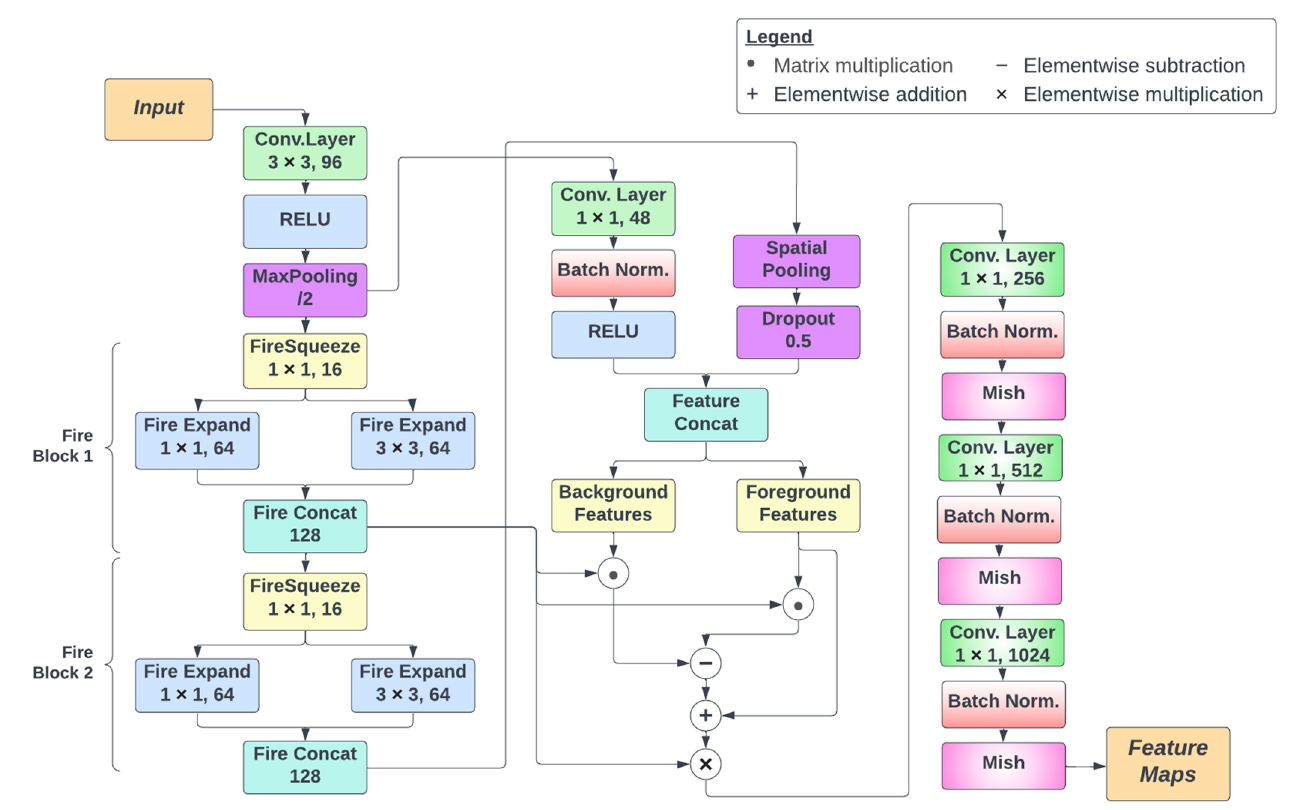
Figure 4. Architectural overview of the Effimix network.